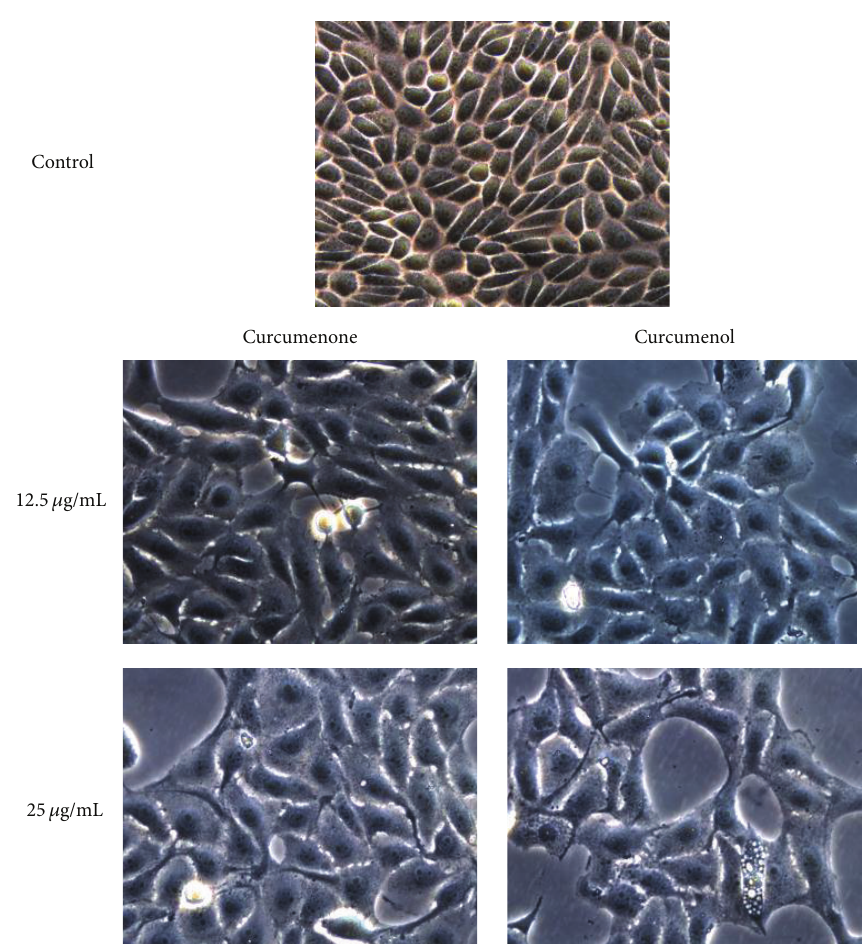
Figure 3: Morphological analysis of MCF-7 cells treated with curcumenone and curcumenol as observed under inverted phase contrast microscope